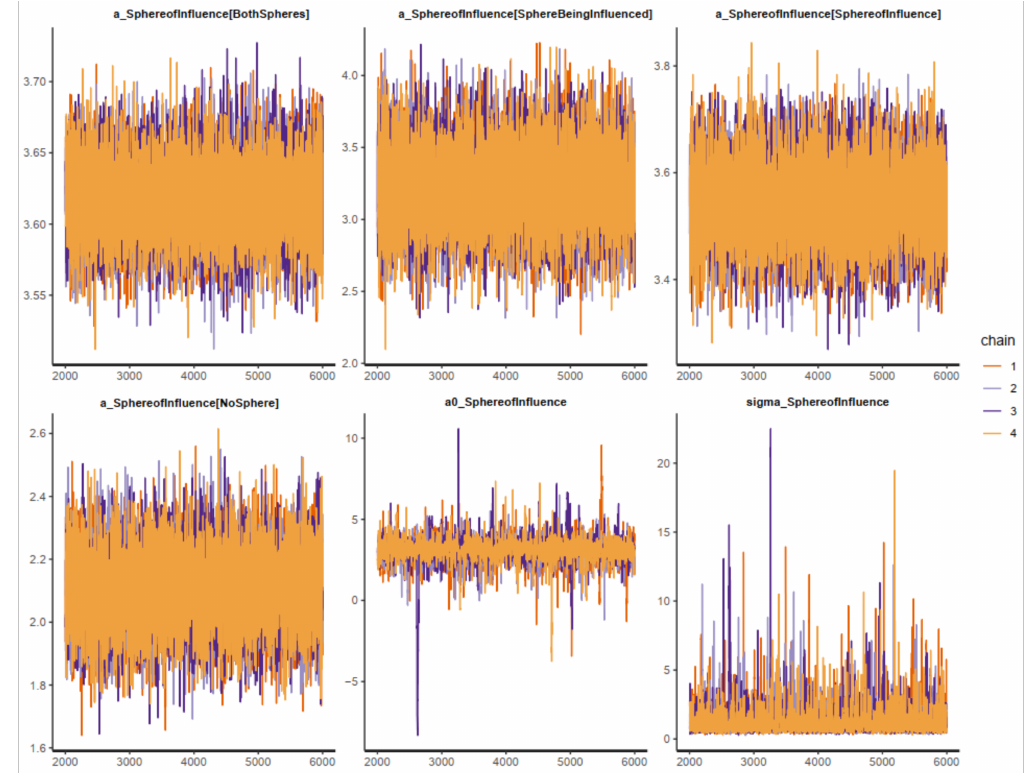
Figure A4. Model 2 (cid:48) s trace plots.